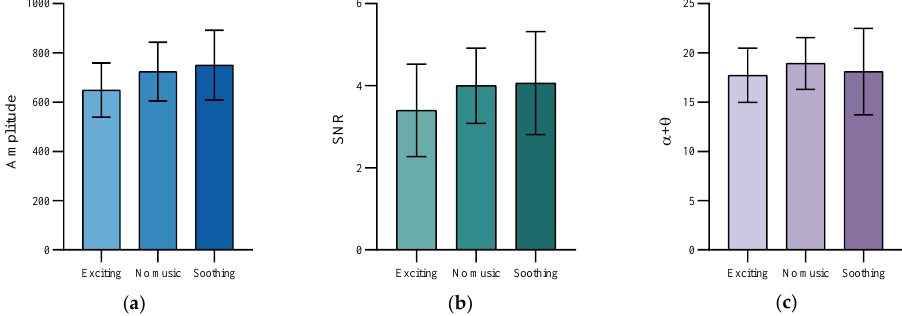
Figure 7. Comparison of the indicators in pre-intervention state under different background music modes. ( a ) Amplitude. ( b ) SNR. ( c ) α + θ band index. As shown in Figure 8, the signal quality of the BCI system is improved in the ex- tended experiment, as both the magnitude and SNR of the SSVEP show an increase after the rest interval adjustment. However, SSVEP amplitude ( F = 12.42, p < 0.05) and SNR ( F = 10.70, p < 0.05) trends varied for different musical modes. The rest interval phase of soothing background music had the greatest effect on enhancing SSVEP amplitude and SNR. At the same time, an ANOVA ( F = 16.56, p < 0.05) was conducted on the α + θ power index for different combinations of musical patterns, and it was found that the soothing background music mode provided the most significant relief of participants’ mental fa- tigue.